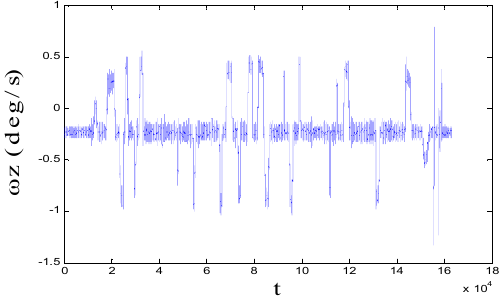
Figure 4. The measurement of data from the z -axis gyroscope.